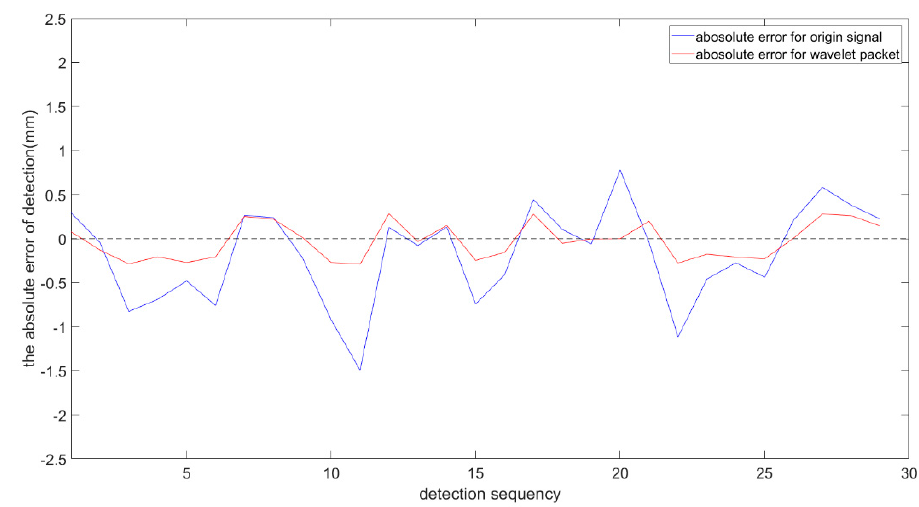
Figure 16. The absolute errors of detection in the experiments. Table 5. Comparison of detection errors at 50 Hz sampling frequency.